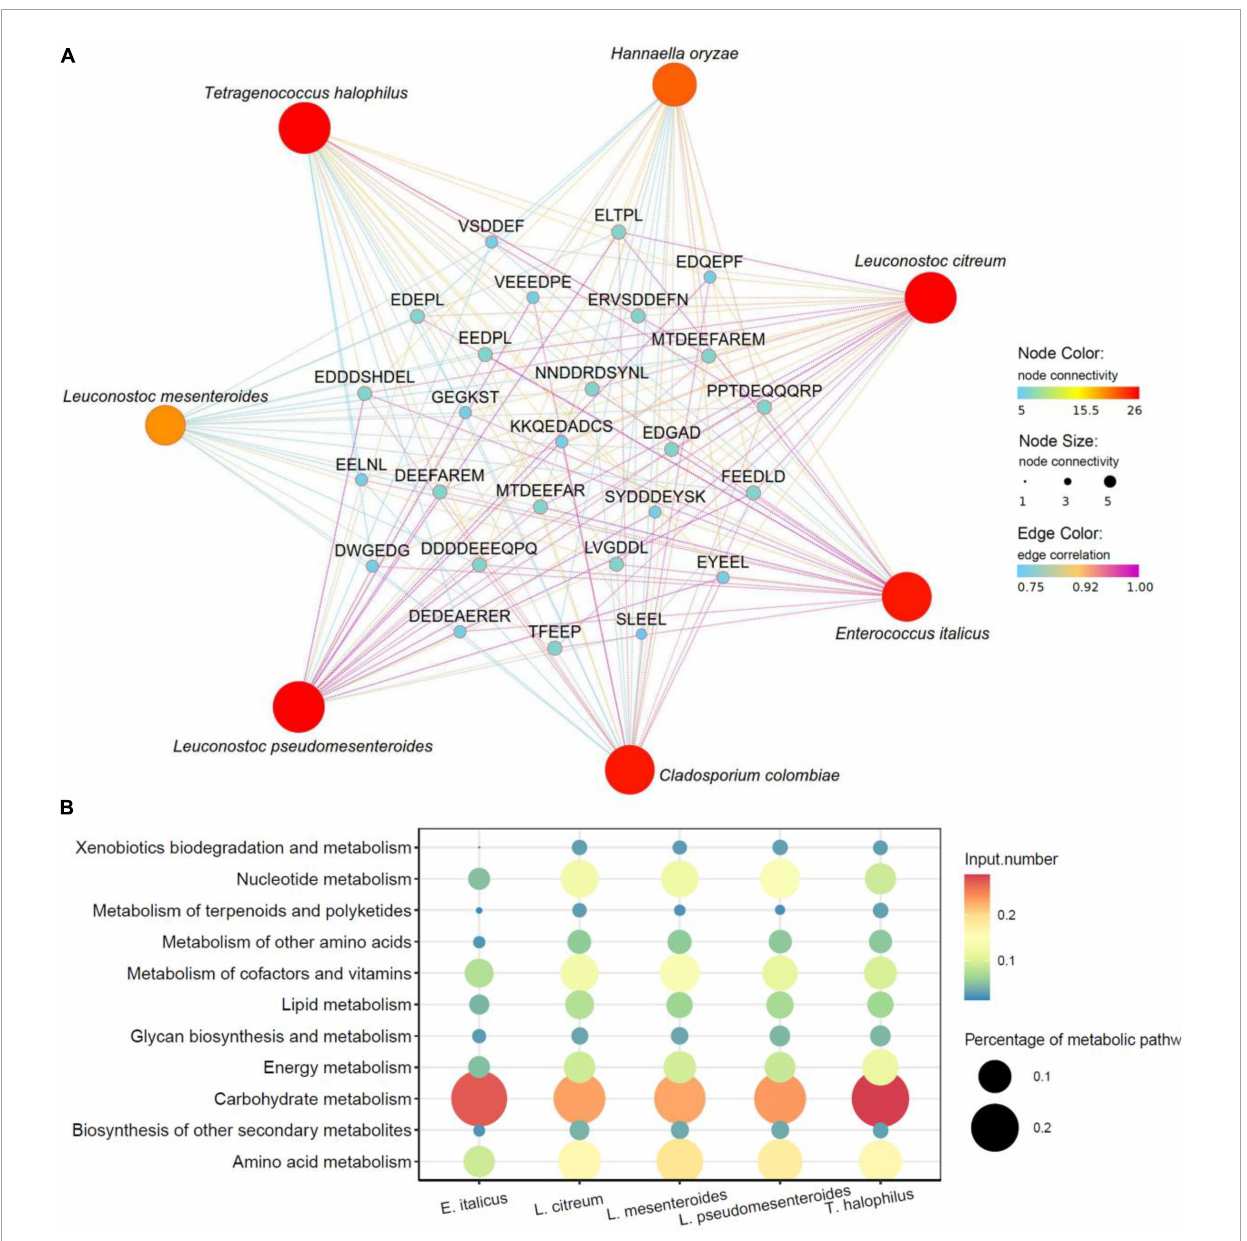
FIGURE8 Correlation of microorganisms and peptides. (A) Correlation network maps based on Pearson’s correlation tests between the umami peptides and microorganisms based on species level. (B) KEGG enrichment analysis from E. italicus , L. citreum , L. mesenteroides , L. pseudomesenteroides and T. halophilus